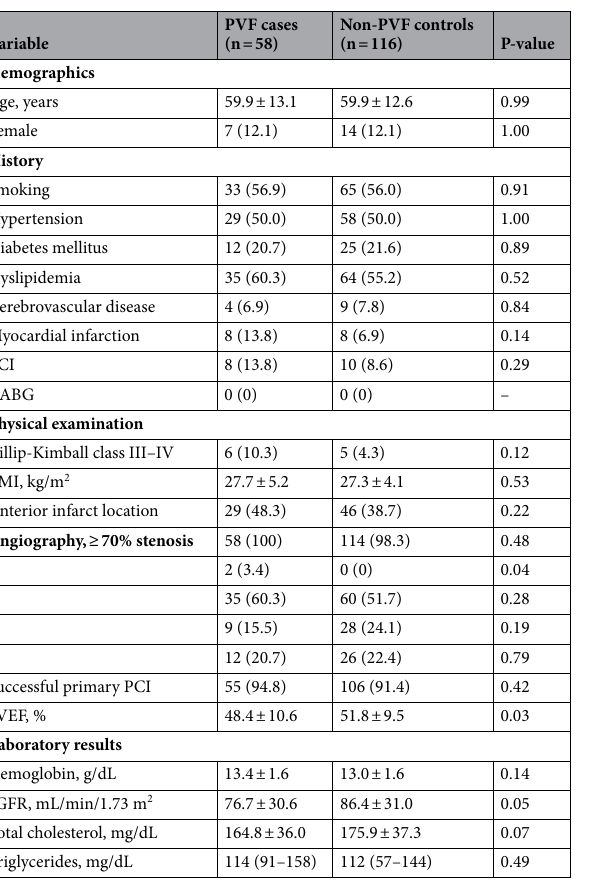
Table 1. Baseline characteristics of primary ventricular fibrillation (PVF) cases and matched controls. Data are presented as n (%), mean ± standard deviation, or median (interquartile range: Q1–Q3). BMI, body mass index; CABG, coronary artery bypass graft; eGFR, estimated glomerular filtration rate; LVEF, left ventricular ejection fraction; PCI, percutaneous coronary intervention. P value obtained by χ 2 test, Student’s t test or Wilcoxon rank sum test, as